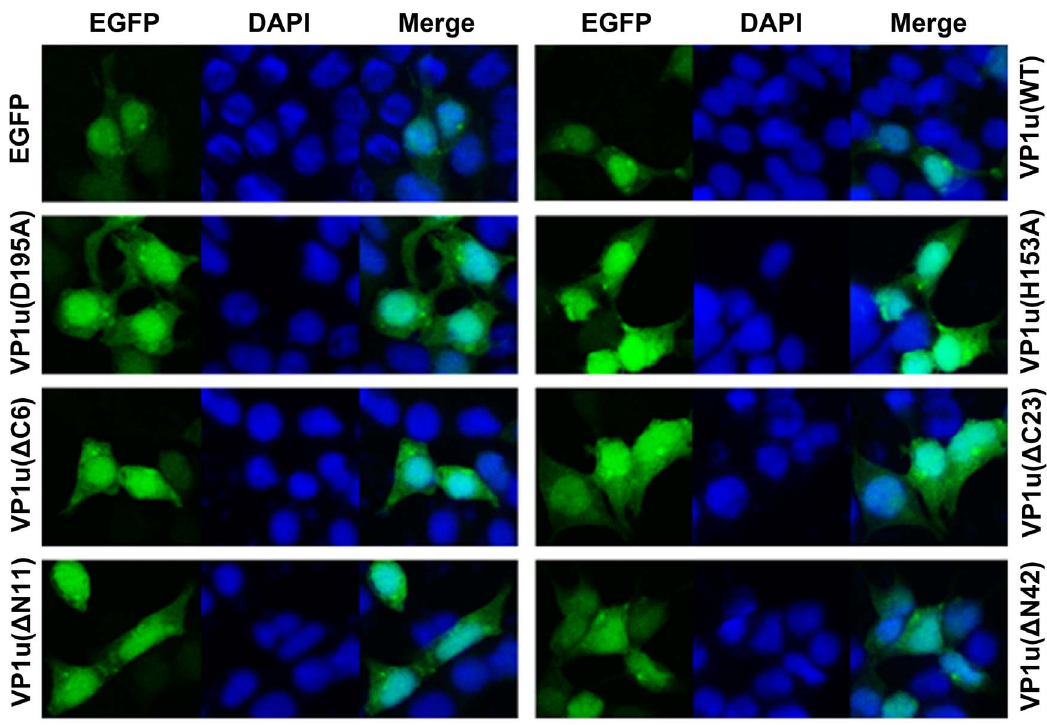
Figure 5. Cellular localization of wild type and mutant VP1u. HEK293T cells grown on cover glass were transfected with indicated plasmids; cells were fixed and analyzed by confocal microscopy at 48 h post-transfection. Green fluorescence showed the distribution of EGFP or EGFP-fused VP1u proteins. Nuclei were stained using DAPI. Confocal images were taken at a magnification of 40 6 .